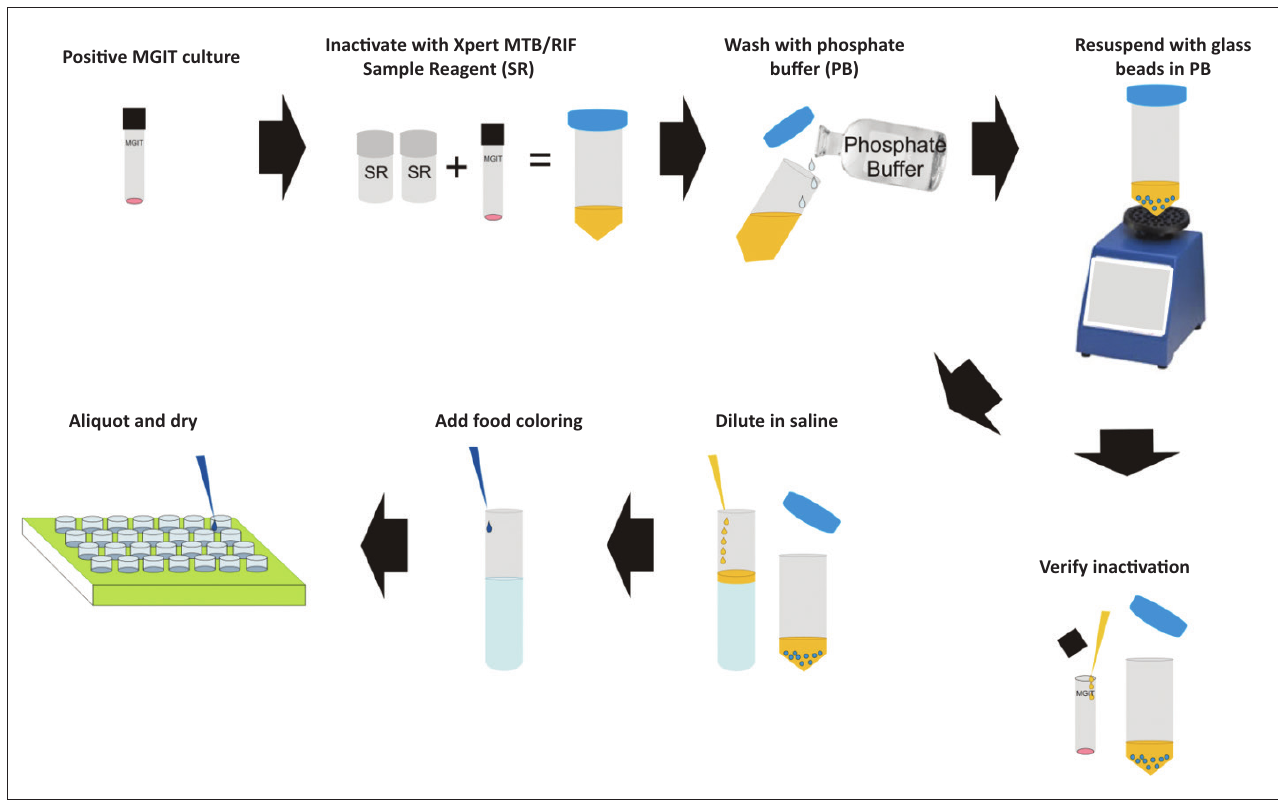
MGIT, Mycobacteria Growth Indicator Tube; PB, phosphate buffer. FIGURE 1: Overview of dried tube specimens for Xpert MTB/RIF preparation procedure, 2013–2015, United States Centers for Disease Control and Prevention (Atlanta, Georgia, United